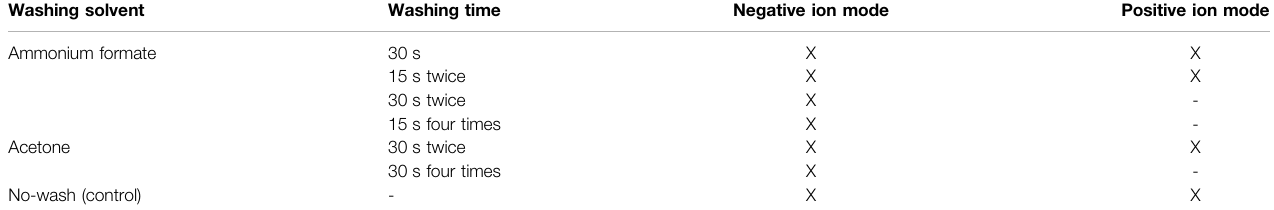
TABLE 2 | Overview of the different washing methods that were applied to the fxh, including the polarity. Washing solvent